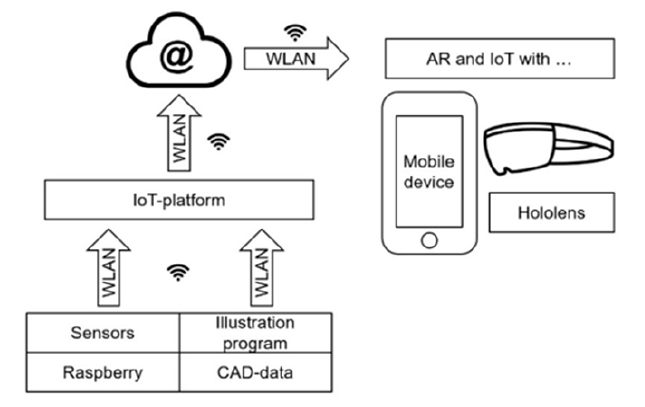
Fig. 1. AR and IoT with